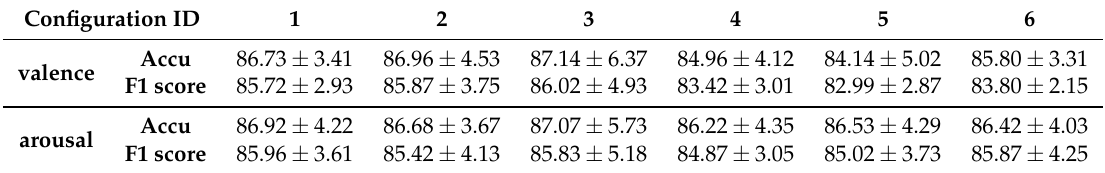
Table 4. The performances of different configurations of ResNet for valence and arousal. The average